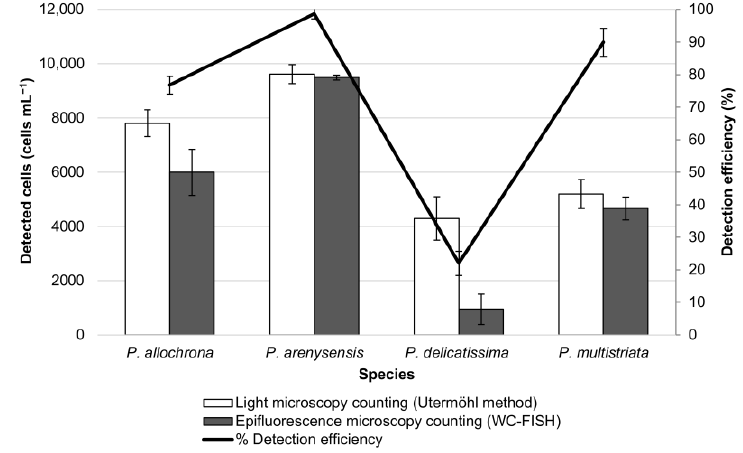
Figure 3. Artificial samples composed of a single monoculture Pseudo-nitzschia species. Cell density (cells mL − 1 ) was estimated before and after WC-FISH. Detection efficiency was calculated as FISH detectable cells (%) by the ratio between cells detected with rRNA FISH targeted probes vs. cultured cells before hybridisation.